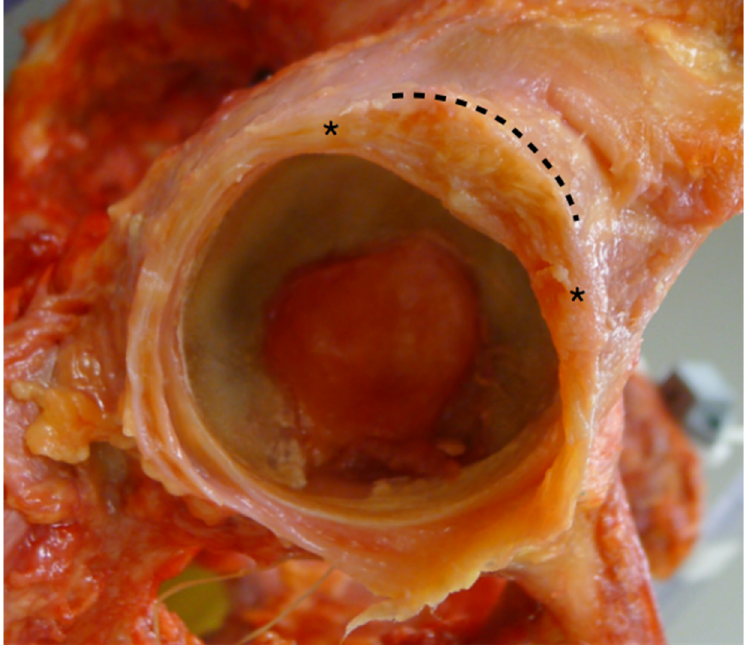
Figure 7. The thickest portion of the anterior capsule, which includes IFL, locates in the anterosuperior region, as marked by asterisk and dotted line.